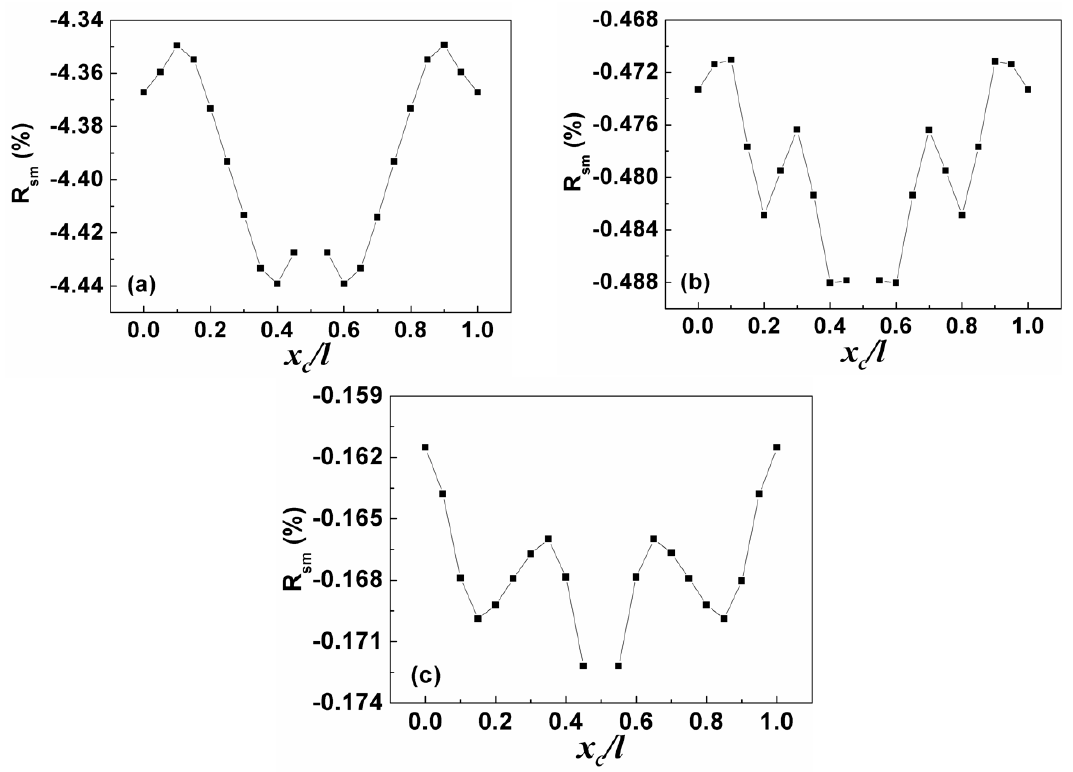
Figure 4. R sm as the function of loading position in the liquid with viscous damping coefficient of 80 N/(m/s) under: ( a ) first-order resonance; ( b ) third-order resonance; and ( c ) fifth-order resonance.